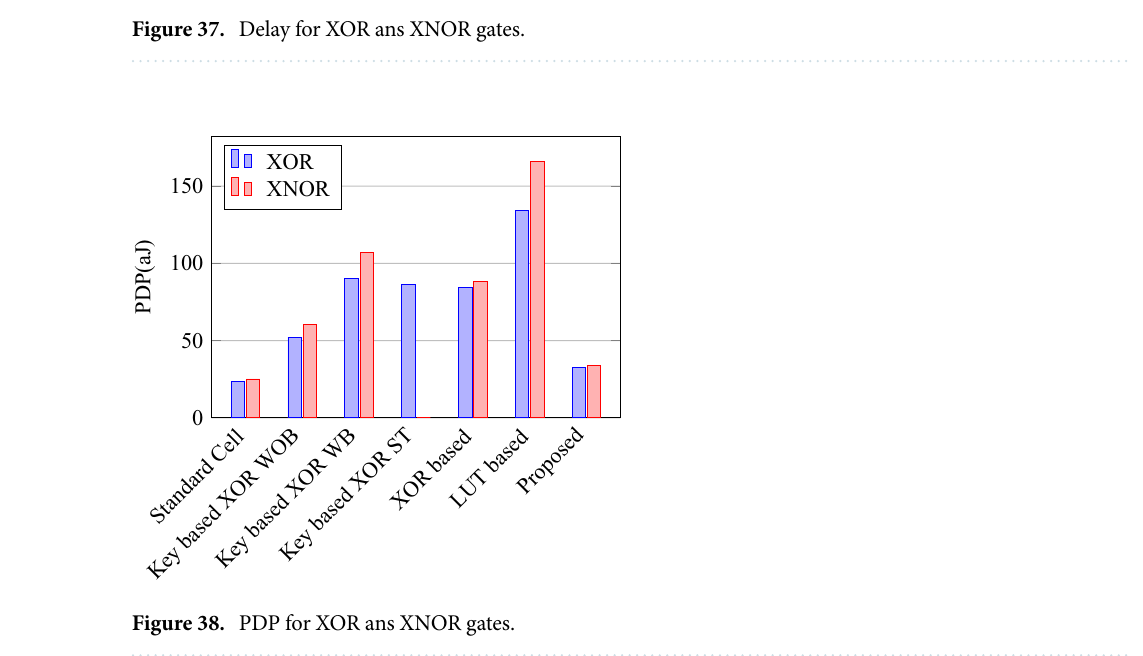
Figure 38. PDP for XOR ans XNOR gates.